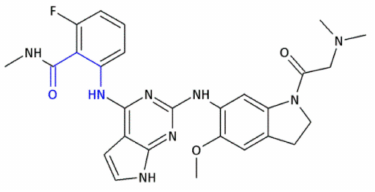
Figure 5. The structure of GSK1838705A